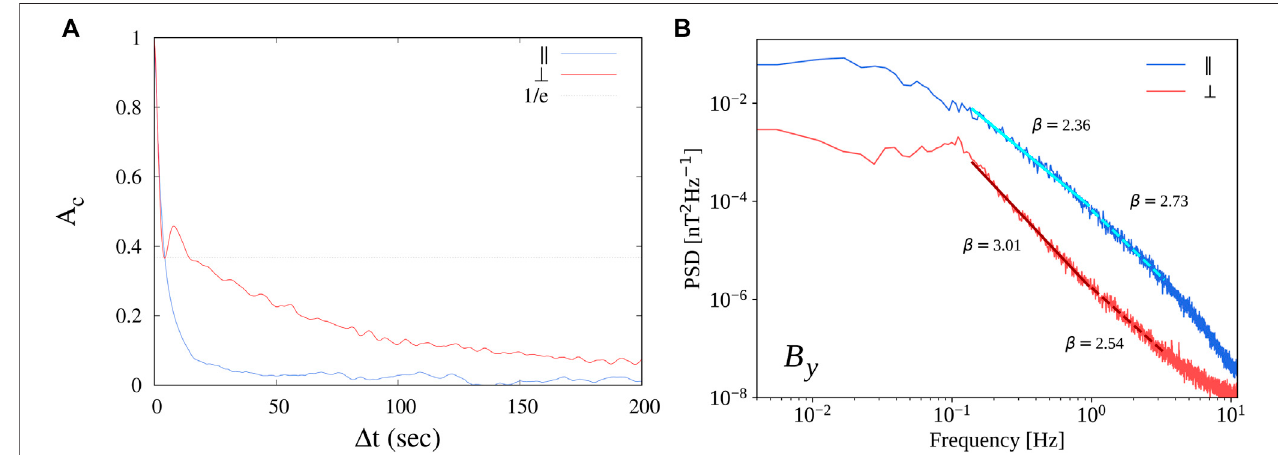
FIGURE2|(A) :autocorrelationfunctionforthetwosamples,averagedoverallcomponentsandallsatellites.Thecorrelationtime,estimatedasthe1/evalueofthe autocorrelation function, is roughly 5 s for both samples. (B) : power spectral density/bfof the magnetic fi eld B y component measured by Cluster 2, for the quasi-parallel ( (cid:3) ,blue) and quasi-perpendicular( ⊥ ,red) samples. Power-law fi tsaresuperposed intwofrequency ranges: larger-scale range infulllines,and thesmaller-scale range in dashed lines. A spectral break is identi fi ed at f ≃ 1 Hz. The respective spectral exponents are indicated, the fi tting error being < 0.03.